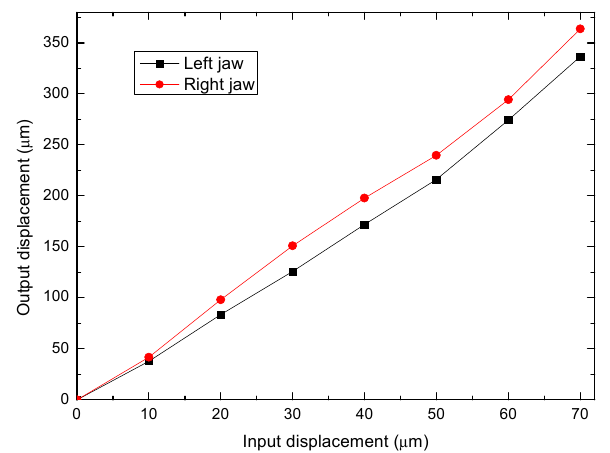
Figure 13. Output of MG jaw (or tip) displacement when an input displacement is applied.